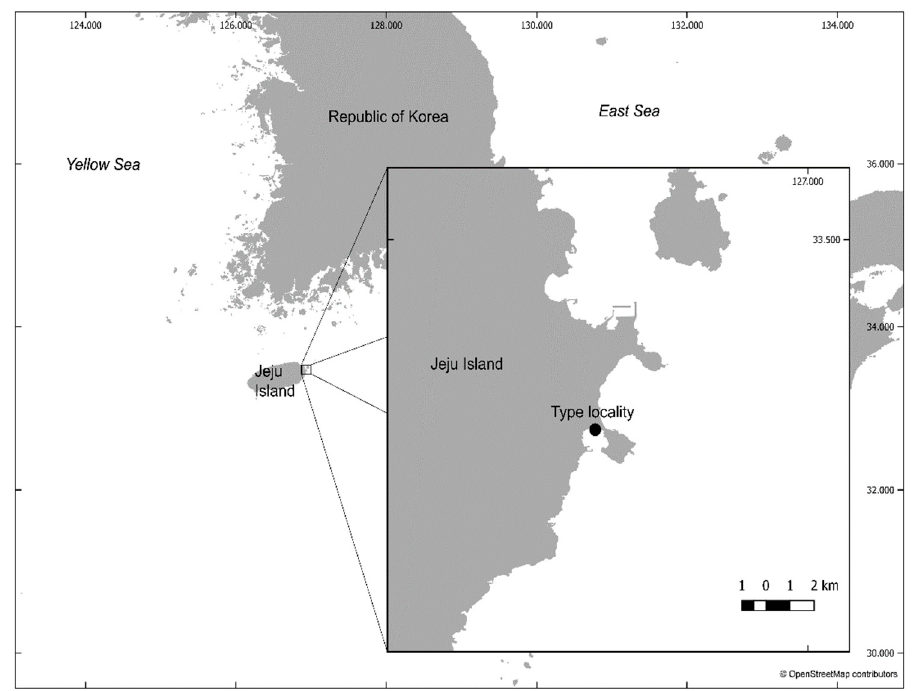
Figure 1. Map of sampling locality. This map is made with QGIS software v.2.18.14, a free and open-source geographic information system (https://qgis.org).